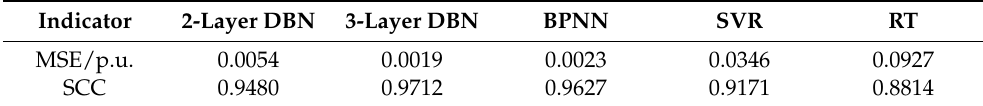
Table 2. Accuracy comparison of each TSI surrogate model on test